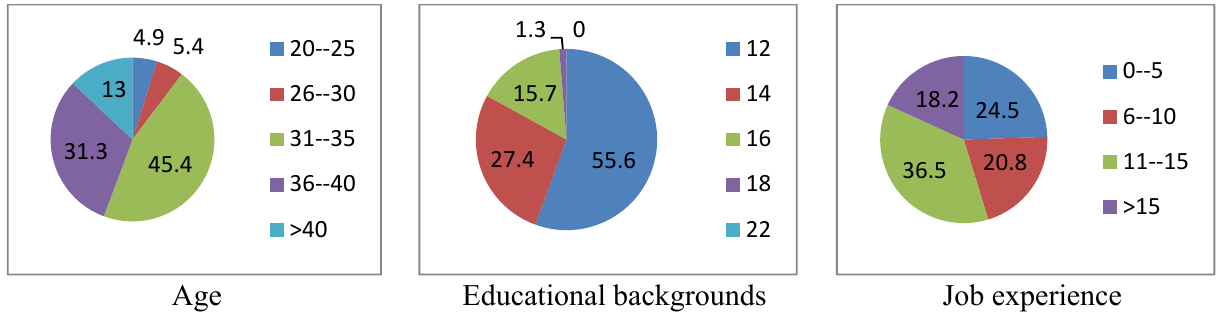
Fig. 1. Personal characteristics of the